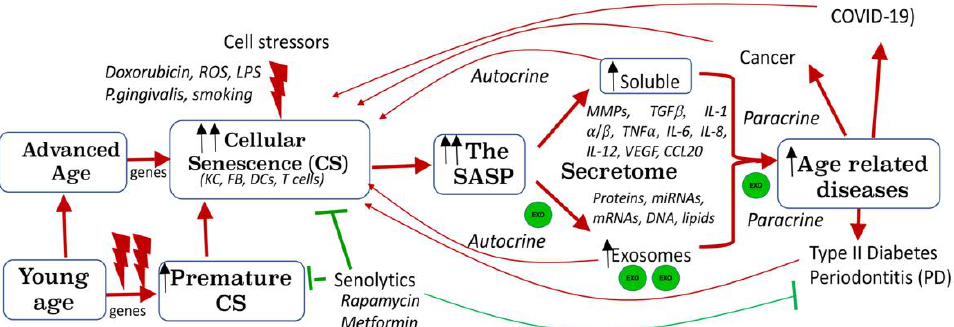
Figure 2. Cellular Senescence due to Advanced Age and Cell Stressors: Role of Exosomes. Advanced age and canonical (e.g., doxorubicin) and non-canonical (e.g., P.gingivalis) cell stressors can provoke cellular senescence (CS). Premature CS can occur by exposure to X irradiation, doxorubicin, reactive oxygen species (ROS), and microbial CS stressors. Senolytic agents (e.g., rapamycin, metformin) can remove senescence cells. CS profiling identifies elevated SA- β -Gal, p16 INK4A, pAkt-1, p53, p21Waf1/Clip1, and soluble and exosomal SASP. Exosomes (exo, green circles) can transmit senes- cence to young cells in paracrine. CS is implicated in many age-related diseases such as periodontitis, type II diabetes and COVID-19.